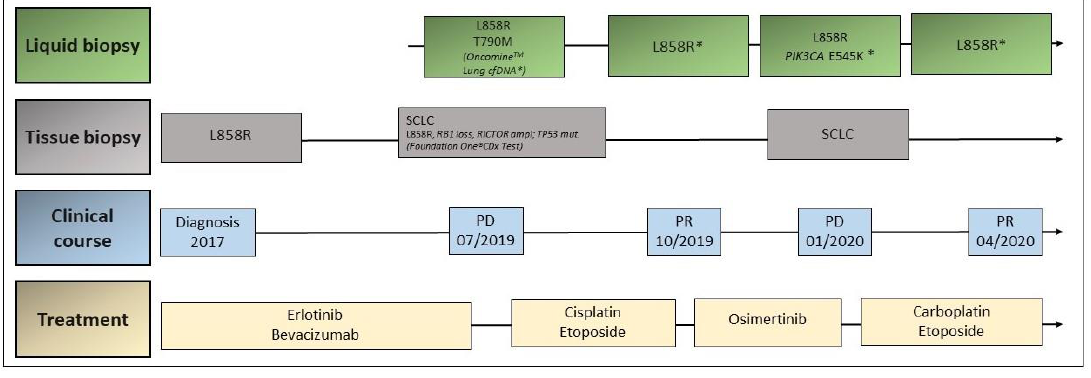
Figure 4. Timeline of disease and treatment course in case 3. Ampl.: amplification; mut.: mutation; PD: progressive disease; PR: partial response; SCLC: small-cell lung cancer.